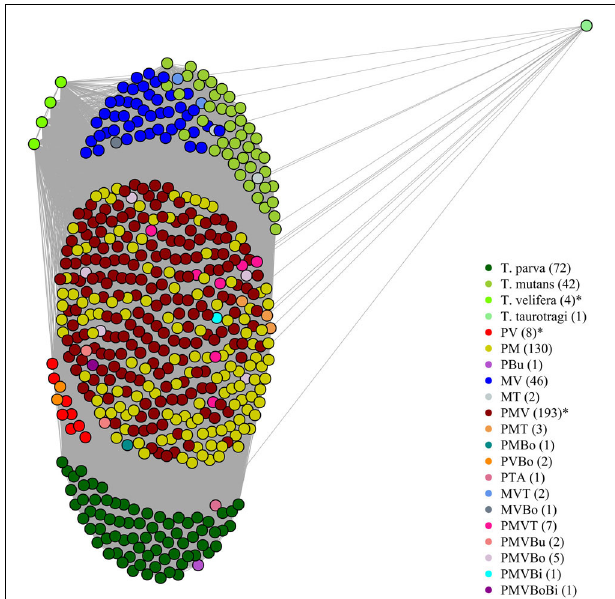
FIGURE 6 | Graphical representation of the structuring of parasite, using parasite network approach, for the dataset described in Salih et al. (2007). The lines width is proportional to the number of individual hosts